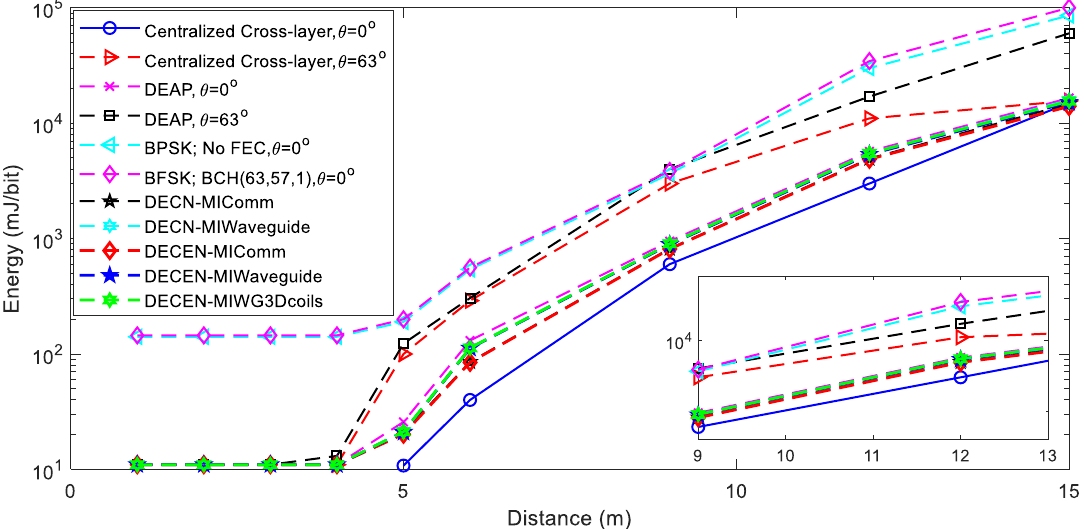
Figure 6. Comparison graph for transmitted energy as a function of distance.